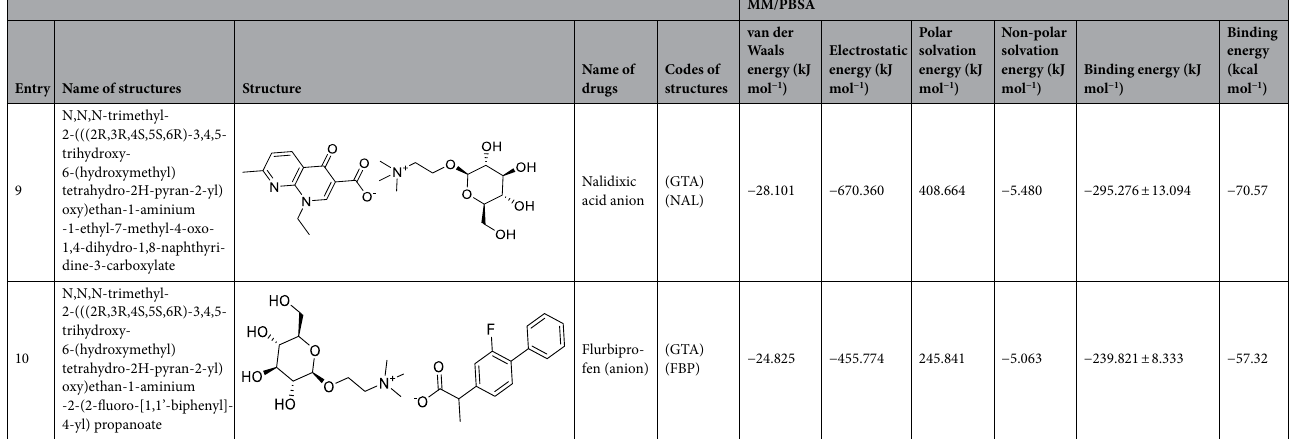
Table 3. Various energy terms obtained through MM/PBSA calculations of ΔE int of the GTA-based ILs and the BMIM-based